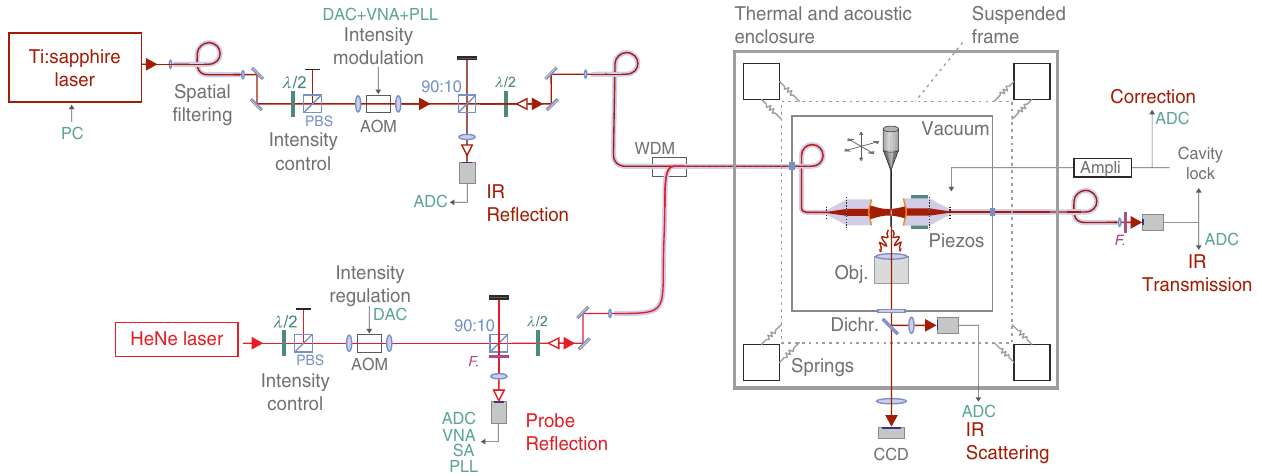
FIG. 5. Detailed experimental setup. (F.: filters, ADC/DAC: inputs/outputs of the acquisition card; Dichr.: dichroic filter; WDM: wavelength combiner; IR: infrared.) The core experiment is realized in a vacuum chamber, mounted on a suspended plate, which hosts the lateral IR scatter detector. The experiment is mounted in a multilayer acoustic and thermal isolation box.